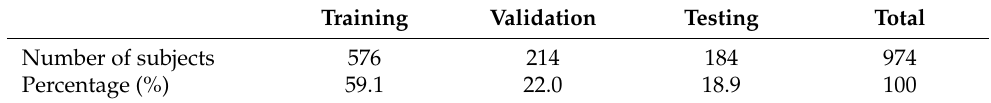
Table 1. The numbers of subjects in training, validation, and testing groups. Training Validation Testing Total Number of subjects